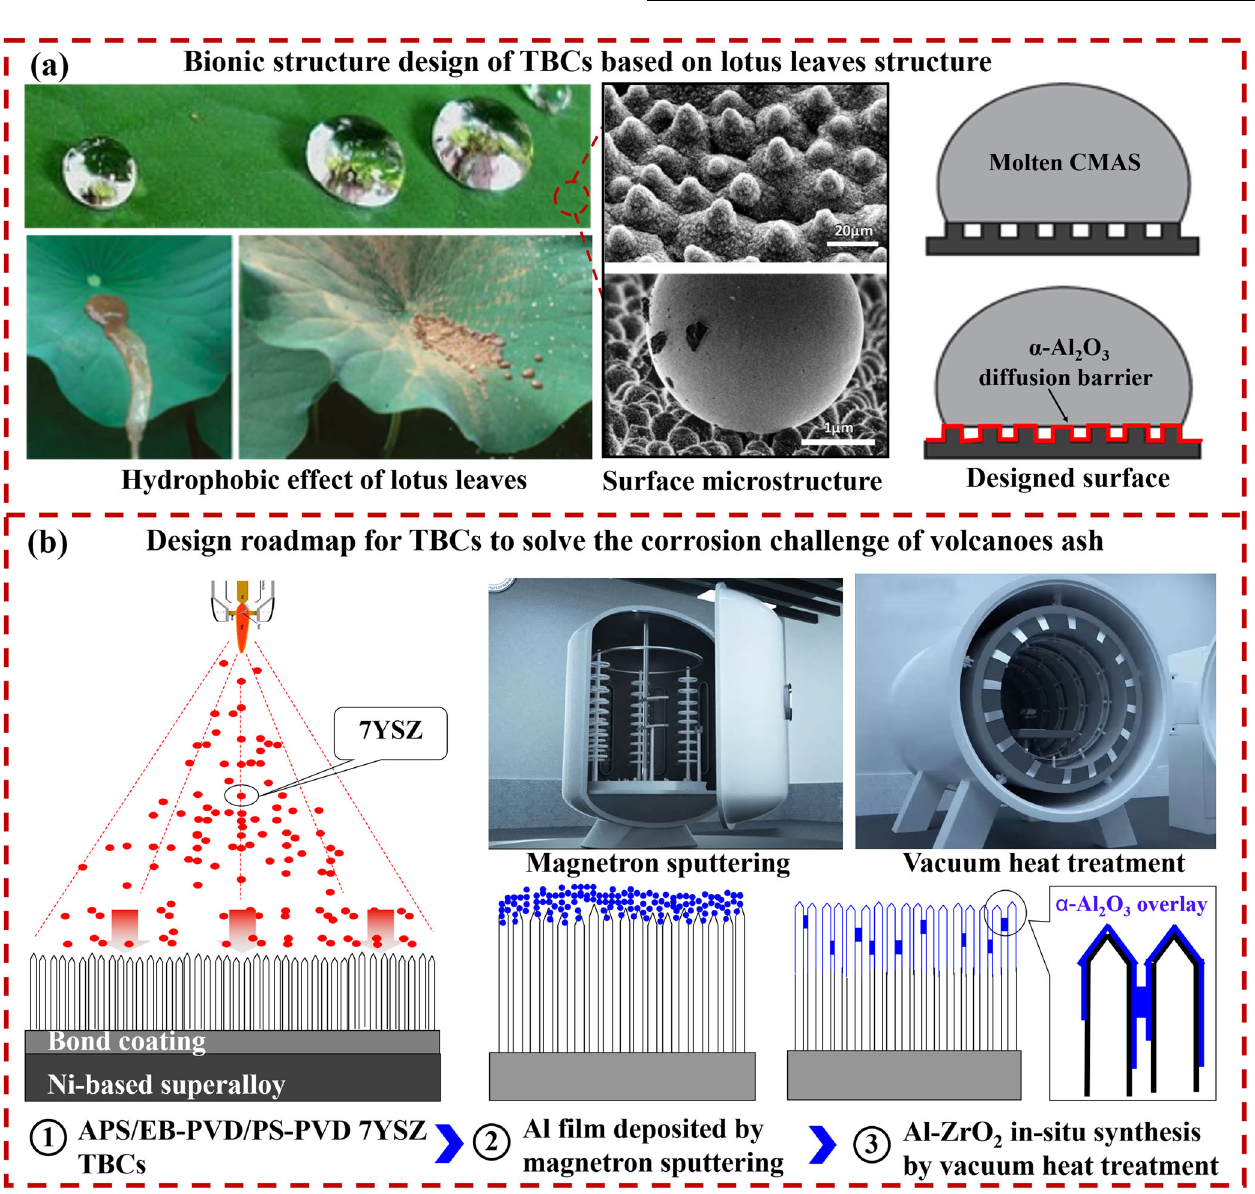
Fig. 2 Surface design of TBCs to prevent CMAS corrosion. a Bionic structural design of TBCs based on a lotus leaf structure. b Al 2 O 3 - modi fi cation process, including TBCs preparation (APS, EB-PVD, and PS-PVD), Al fi lm deposition by magnetron sputtering, and vacuum heat treatment of Al-deposited